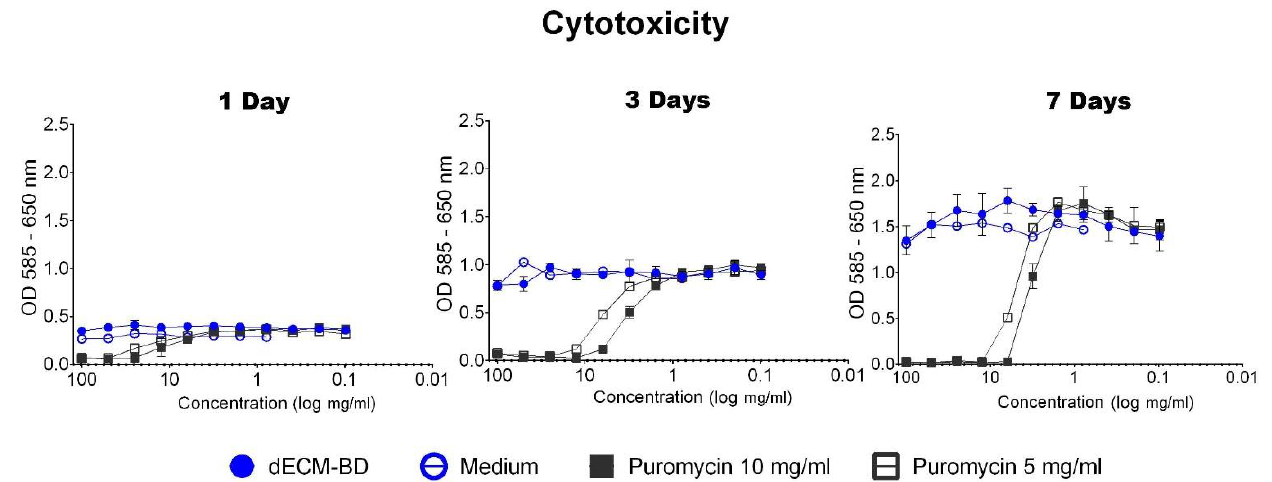
Figure 4. Cytotoxicity evaluation of the dECM-BD. Optical density plotted against the serially diluted conditioned medium (CMe) from decellularized extracellular matrix bile ducts (dECM-BD) at three different time points (log scale). PK84 fibroblasts were treated with dECM-BD CMe, cell culture media (negative control for cell death), and two different concentrations of puromycin, to induce a positive cytotoxic response. Results are presented as mean with a standard error of the mean of triplicates of three independent donors.